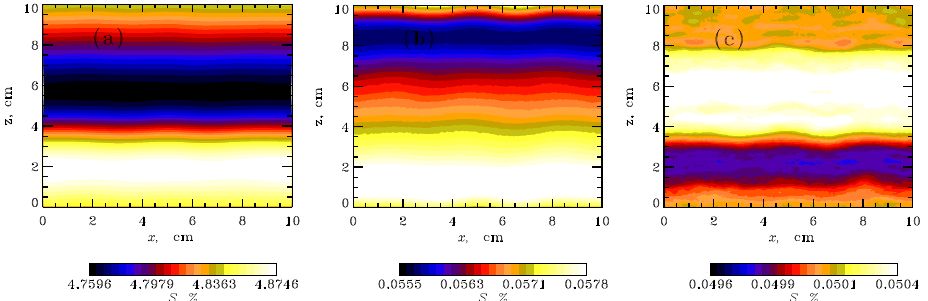
Figure 3. Distribution of supersaturation at t = 3s in case 1 (a) , case 2 (b) and case 3 (c) , (see Table 1). Non-equilibrium case with low intensive turbulence is considered (see Table